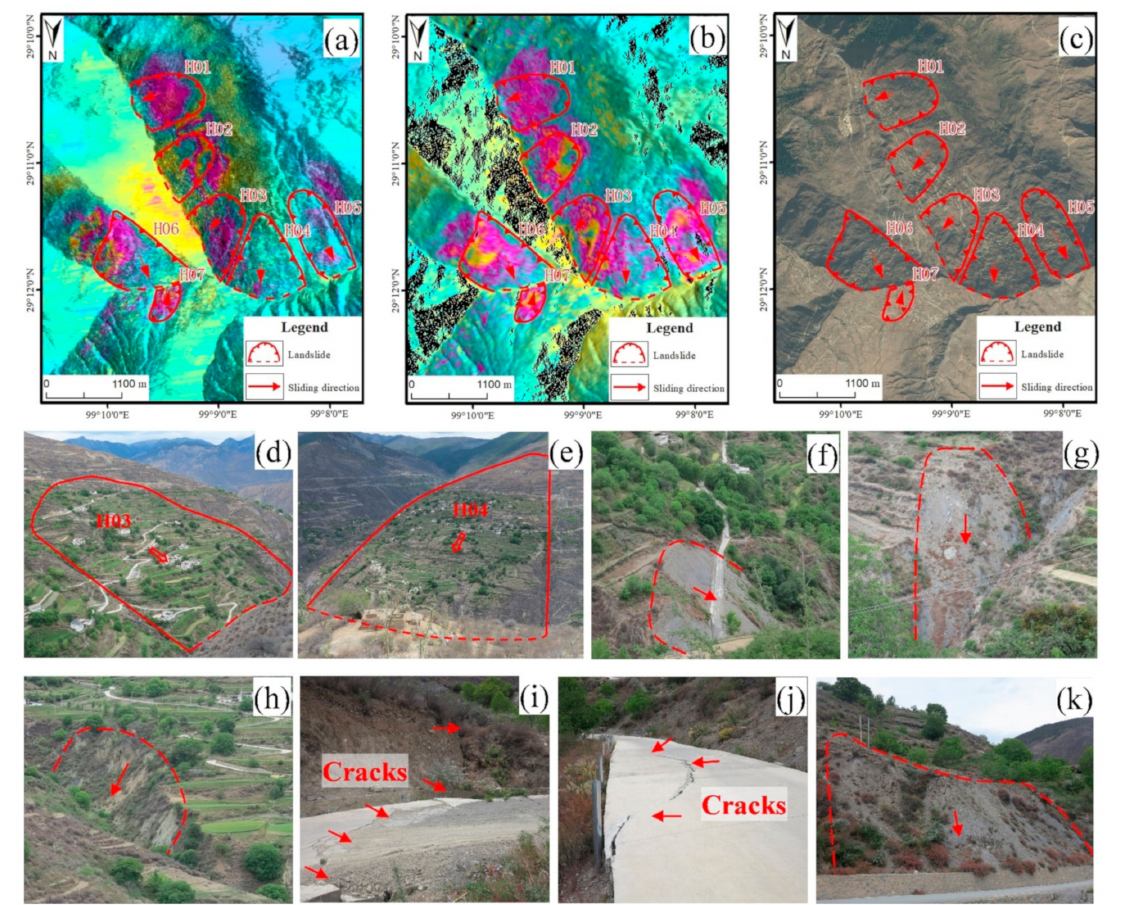
Figure 20. InSAR identification results and on-site verification photos of the local area. ( a ) The result of ALOS-2 data; ( b ) the result of Sentinel-1 data; ( c ) optical satellite image of the area; ( d ) site photo of H03 landslides; ( e ) site photo of H04 landslides; ( f ) photo of deformation characteristic of H03 landslide; ( g ) photo of deformation characteristic of H01 landslide; ( h ) photo of deformation characteristic of H02 landslide; ( i ) photo of deformation characteristic of H05 landslide; ( j ) photo of deformation characteristic of H06 landslide; ( k ) photo of deformation characteristic of H07 landslide. Red arrows in ( d – h , k ) indicate the sliding direction. Red arrows in ( i , j ) indicate the location of cracks.